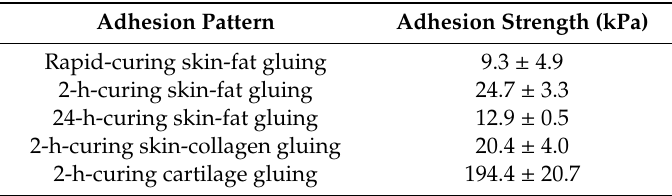
Table 1. Adhesion strength of double cross-linked tissue adhesive hydrogel (DCTA) under di ff erent conditions. Reproduced with permission from Ref. [72], Copyright 2016, Acta Materialia Inc.